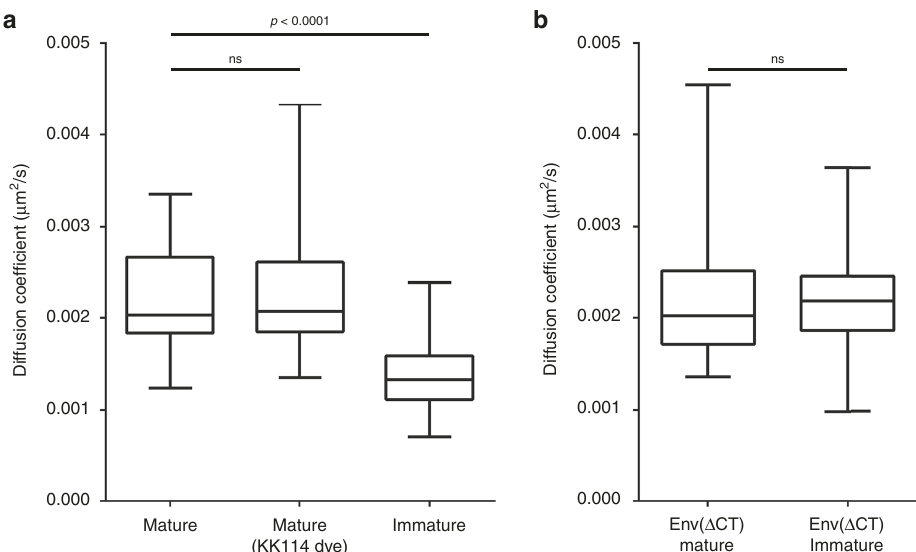
Fig. 3 Diffusion coef fi cients of HIV-1 Env in mature, immature and Env C-terminal tail truncated particles. Median Env diffusion coef fi cients ( D ) were determined by sSTED-FCS measurements of 50 particles each from two independent virus preparations. Results are shown in a box (IQR) and whisker (min/max) plot and the statistical signi fi cance was assessed by Wilcoxon rank-sum test. ( a ) D -values of mature, immature and mature particles labelled with an alternative dye (KK114). ( b ) D- values of mature and immature particles pseudotyped with Env( Δ